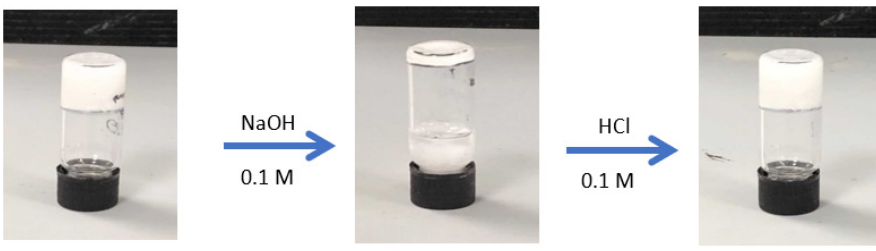
Figure 6. pH response of G1.